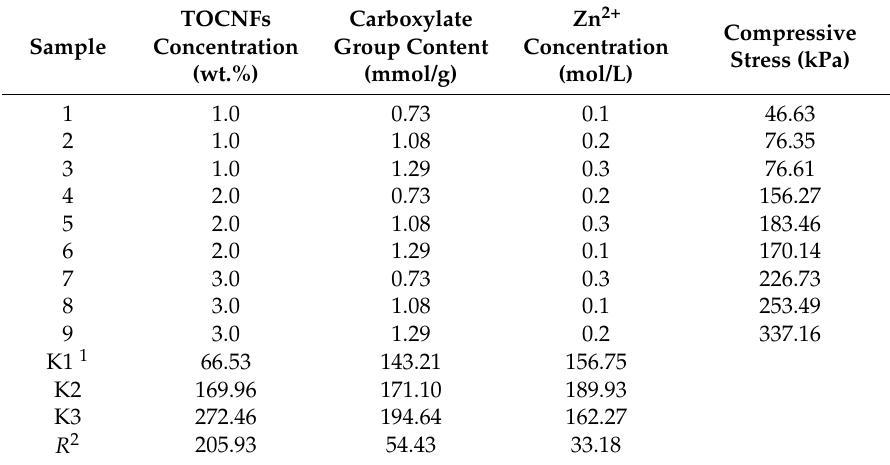
Table 2. Orthogonal experiment for CNFs hydrogels